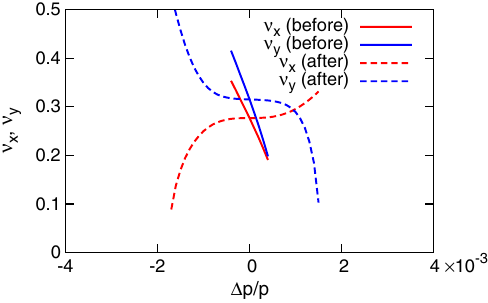
FIG. 11. Chromatic dependence of the fractional betatron tunes before and after the chromaticity compensation up to 2nd order.